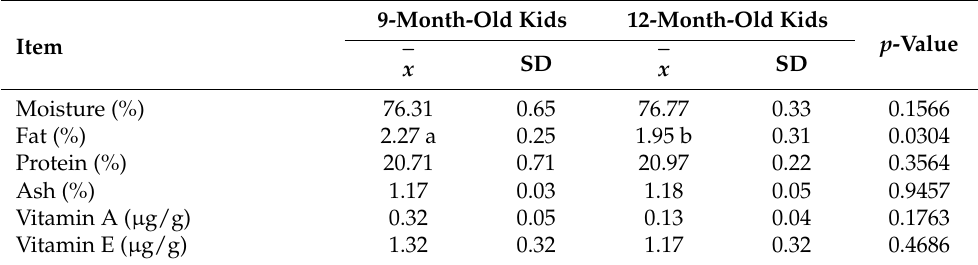
Table 2. Chemical composition of kid’s meat.